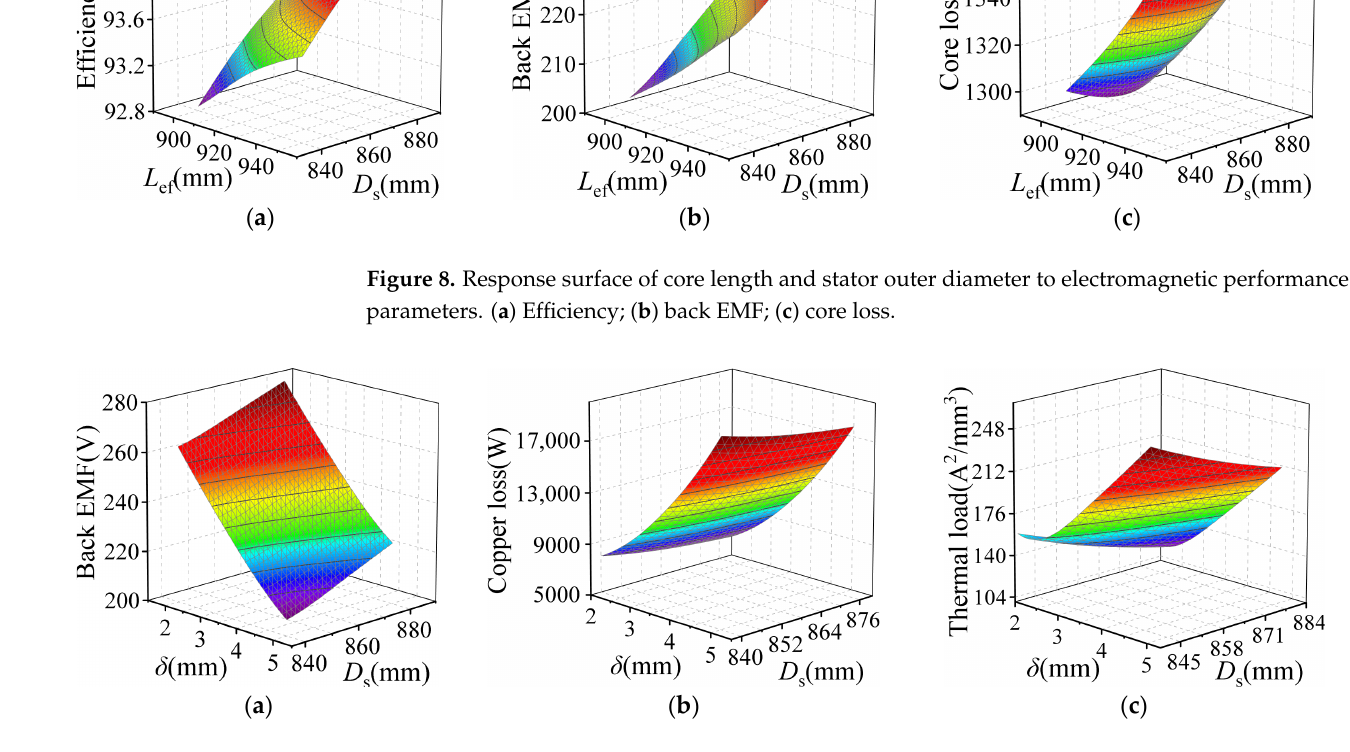
Figure 9. Response surface of air gap length and stator outer diameter to electromagnetic performance parameters. ( a ) Back EMF; ( b ) copper loss; ( c ) thermal load.